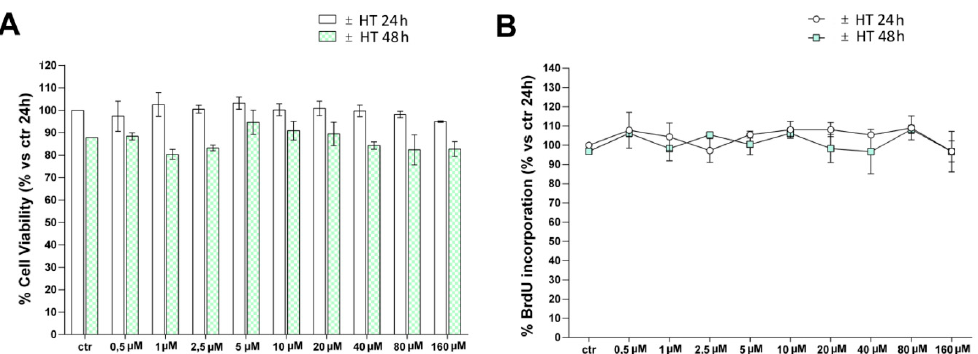
Figure 1. Evaluation of HT effect in HUVECs. HUVECs were cultured for 24 h or 48 h with different concentrations of HT (0–160 µM), before MTT assay ( A ) or BrdU incorporation ( B ). Results are expressed as mean (± SD), and are representative of four independent experiments carried out in triplicate. Data are reported as percentage vs. control (untreated cells at 24 h) (2-way ANOVA).